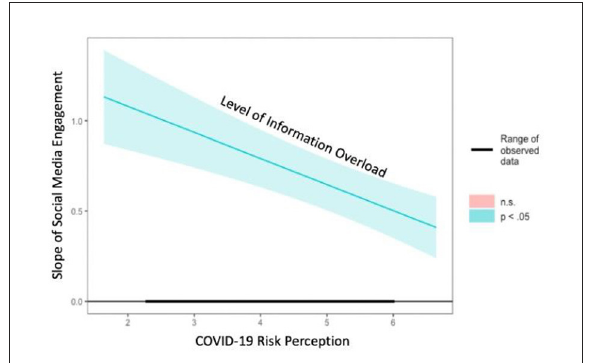
FIGURE3 Johnson-Neyman plot for the interaction effect between risk perception and social media engagement on IO.